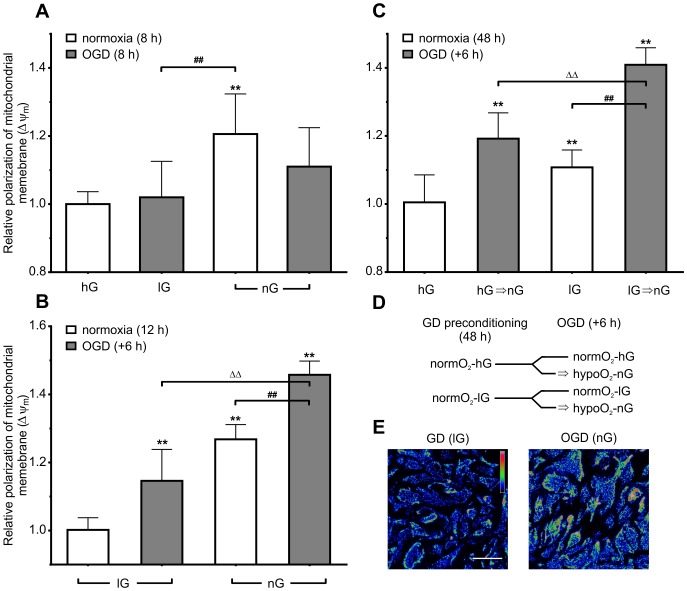
Glucose deprivation leads to hyperpolarization of Δψm after both normoxic and OGD conditions.(A) Glucose deprivation for 8 h increases the ratio of JC-1 fluorescence. This effect was not detected when combining GD and OD, but level of significance was noticable low (p = 0.059). (B) Preconditioning for 12 h with media containing reduced or no glucose promotes hyperpolarization after OGD during simulated reperfusion. After preconditioning, astrocytes were subjected to hypoxic conditions for additional 6 h (grey bars) or they were maintained in normoxic conditions (white bars). (C) Lowering glucose in the incubation medium leads to an increased ratio of JC-1 fluorescence during simulated reperfusion after normoxic and OGD conditions. There was significant interaction between effect of glucose in the culturing media and the effect of OGD. Astrocytes were incubated for two days either in hG or lG medium. Subsequently, OGD was conducted for 6 h (grey bars). (D) Schematic representation of the experimental design of C. The duration of each step is shown in brackets. (E) Representative red signal from fluorescent micrographs of astrocytes labeled with JC-1. Original micrographs were converted to rainbow pseudocolor pallete using LUTs (ImageJ 1.48a). Increase in red fluorescence is observed when astrocytes are incubated in OGD in nG medium as compared to normoxic conditions in lG medium (Fig. 2B). The scale bar represents 100 µm. Data are expressed as a percentage normalized to the JC-1 red/green fluorescence ratio values of untreated control astrocytes (first bar on the left). Significant differences are indicated by **p<0.01 with respect to control (normoxia in hG for Fig. 3A and 3C, normoxia in lG for Fig. 3B), ##p<0.01 between normoxia and OGD (in lG or nG), ΔΔp<0.01 between two OGD treatments.